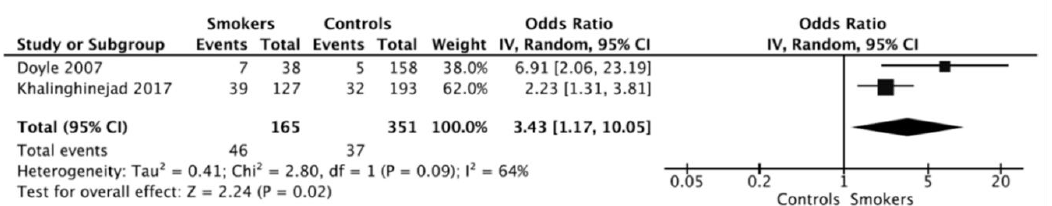
Figure 2. Funnel plot for estimates in meta-analysis of extracted root-filled teeth (RFT) in smoker subjects. Studies with higher power and lower standard error are placed towards the top. Studies with lower power are placed towards the bottom. 1. Doyle et al. (Scott L. Doyle et al., [20]) and 2. Khalighinejad et al. (Khalighinejad et al., [42]).